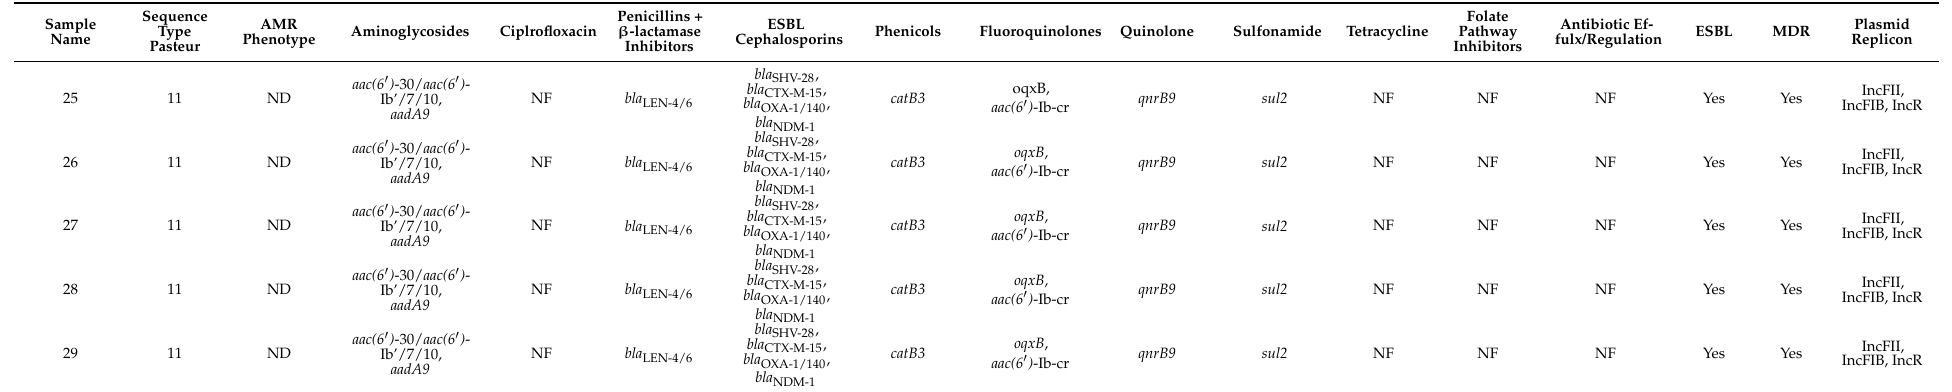
Table 3. Genomic characteristics of uropathogenic K. pneumoniae strains isolated in this study for acquired AMR-associated genes and plasmid replicon types. NF means not found; ‘Yes’ means the strain is either ESBL-producing or MDR; and ‘No’ means the sample is either non-ESBL or